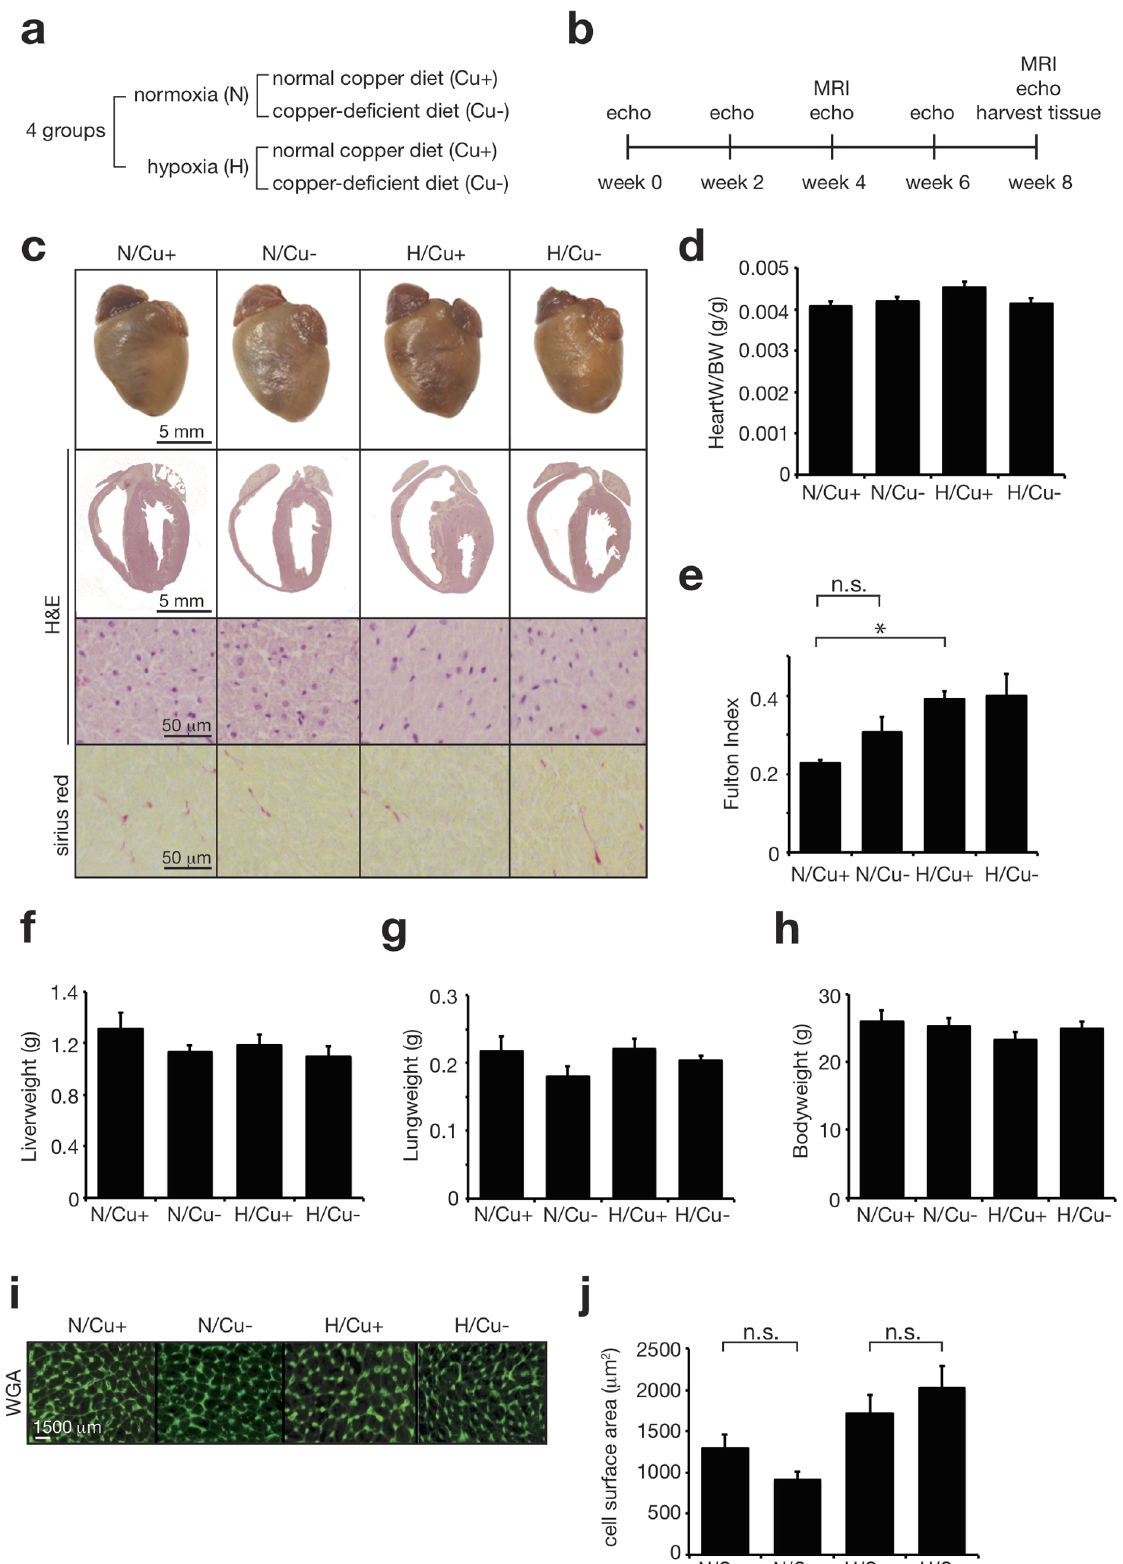
Figure 1. Chronic hypoxia leads to an increase in Fulton index. (a) Experimental groups. (b) Study design. (c) Representative images of whole hearts (upper panels), haematoxylin & eosin (H&E) stained 4-chamber paraffin sections (second panels), high magnification H&E stained free right ventricular wall histological sections (third panels), high magnification sirius red stained free right ventricular wall sections (lower panels. The